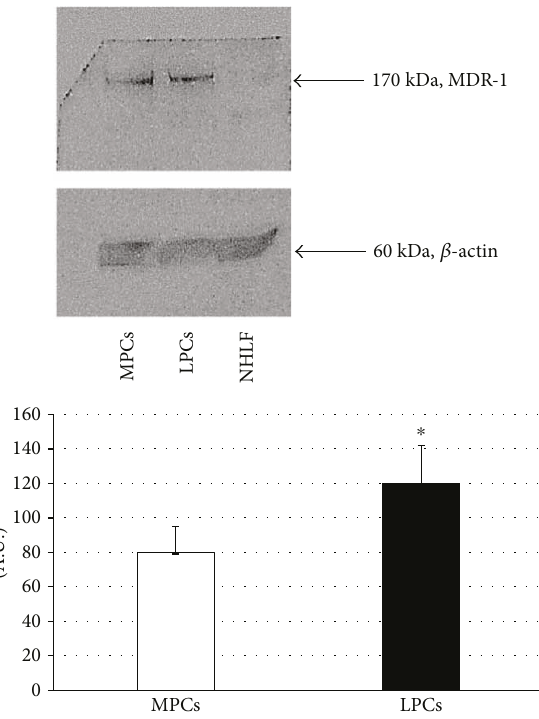
Figure 4: Western blots and densitometric analyses of MDR1 expression. (Top) representative Western blot gels showing the bands of MDR1 and of the endogenous control β -actin. (Bottom) densitometric analyses of the immunoreactive bands (quanti fi ed as MDR1/ β -actin bands in corresponding samples and expressed as arbitrary units, A.U.). Data are mean ± SD of analyses performed in MPCs and LPCs from the 12 patients. ∗ p < 0 05 LPCs versus MPCs. MPCs: myometrium progenitor cells; LPCs: leiomyoma progenitor